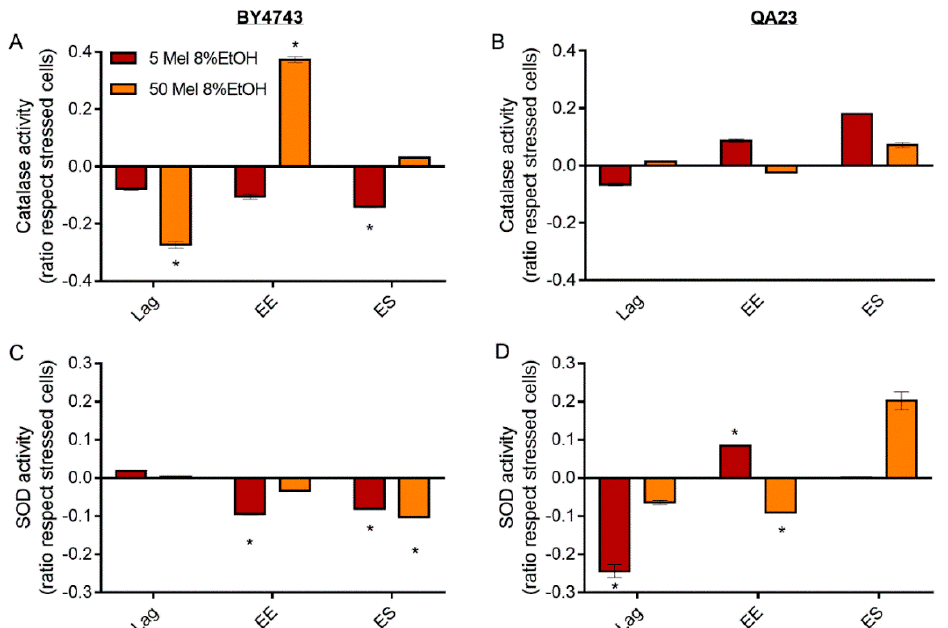
Figure 7. Effect of melatonin (Mel) supplementation (5 (red) or 50 (orange) µ M) of BY4743 ( A , C ) and QA23 ( B , D ) cells exposed to 8% ethanol in lag, early exponential (EE), and early stationary (ES) phases on ( A , B ) catalase activity and ( C , D ) superoxide dismutase (SOD) activity (ratio of the enzymatic activity of stressed cells with Mel vs. stressed cells without Mel). Error bars represent the standard deviation, * indicates significant differences with respect to stressed cells without melatonin ( p -value < 0.05), and in Supplementary Table S6, there is a more complete statistical analysis.